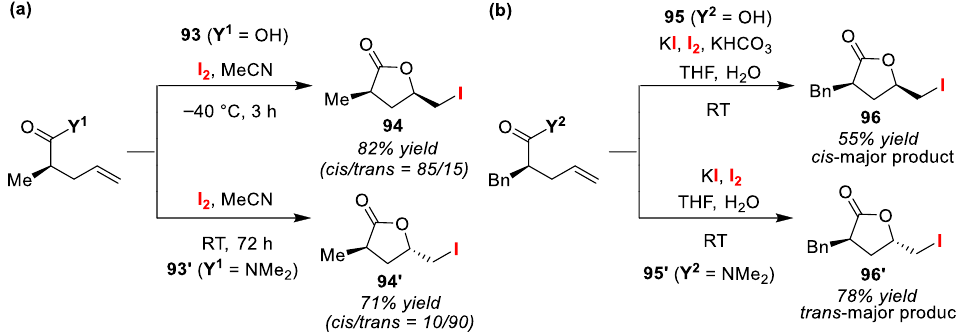
Figure 45. Cis/trans stereoselective iodo-lactonizations of olefinic acids ( 93 and 95 ) and amides ( 9 3′ and 9 5′ ) using I 2 .